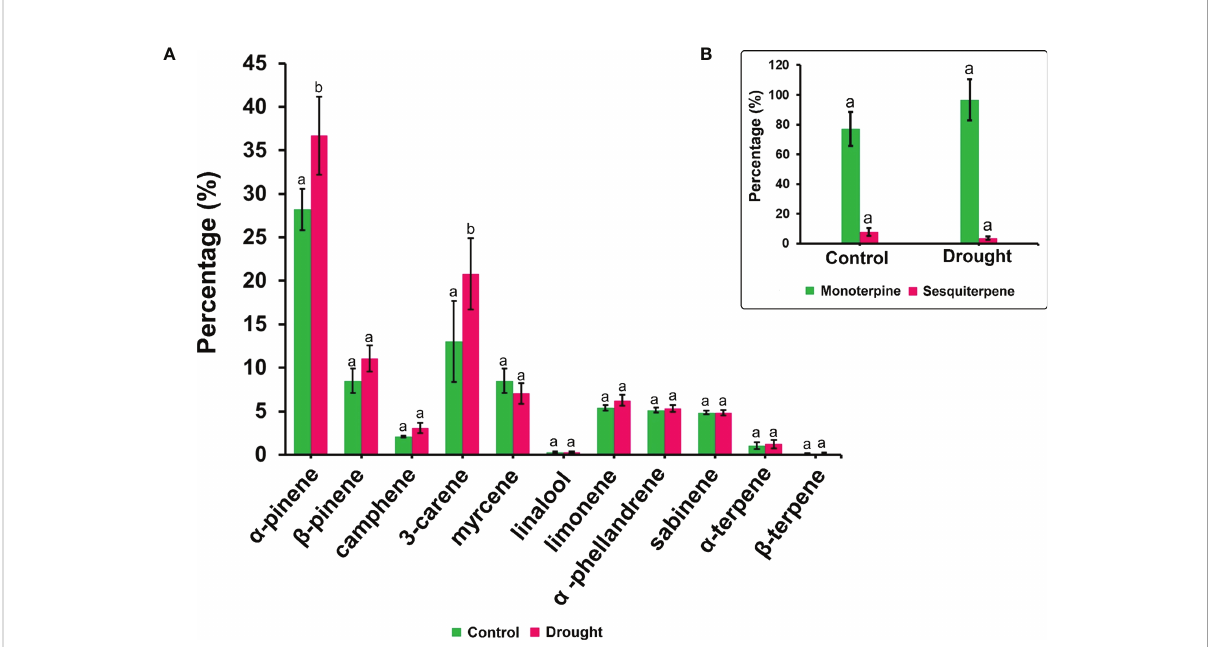
FIGURE 4 Volatile synthesis (VOC)-Monoterpenes. (A) major monoterpenes and their content in root samples (B) total accumulation of main monoterpenes and sesquiterpenes in root samples measured 32 DAT. Results indicate the in fl uence of severe drought on the signi fi cant accumulation of two critical monoterpenes a -pinene and delta-3-carene apart from a non-signi fi cant increase for other critical monoterpenes like b -pinene, camphene and limonene. Signi fi cant accumulation of total monoterpene content is noted compared to drought treated seedling samples. Means denoted with different letters indicate signi fi cance at